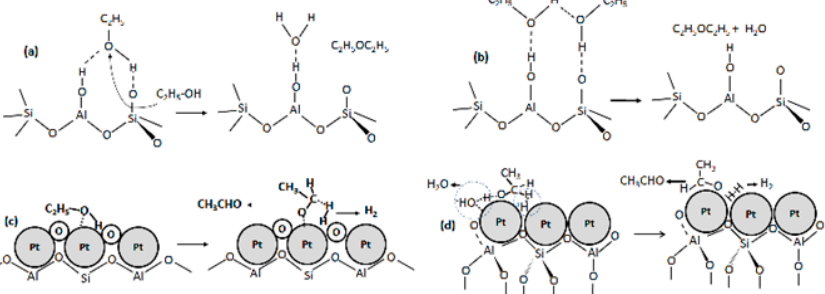
Figure 5. Reaction mechanisms of ( a ) DEE formed on NaY-SiO 2 via hydrogen bonded monomer, ( b ) DEE formed on NaY-SiO 2 via ethanol dimer intermediate, ( c ) acetaldehyde formed on platinum oxides of Pt/NaY-SiO 2 , and ( d ) acetaldehyde formed on platinum of Pt/NaY-SiO 2 .